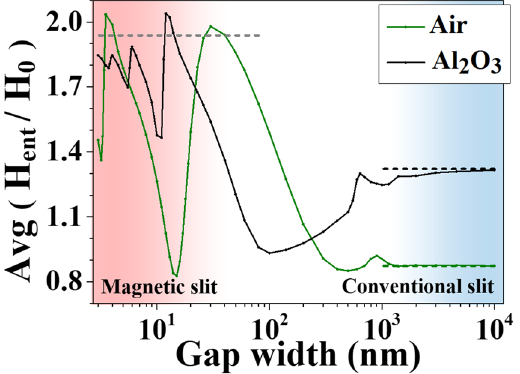
Figure 4. Magnetic field amplitude at the gap entrance versus the gap width with normal incidence for gap dielectrics of Al 2 O 3 (black solid line) and air (green solid line). For widths below 100 nm, the gap field amplitude oscillates around the value given by the Fresnel equations (gray dashed line). Whereas, the field amplitude in conventional macroscopic slits converges to the value of the dielectric thin film (black and green dashed lines), regardless of the side metal